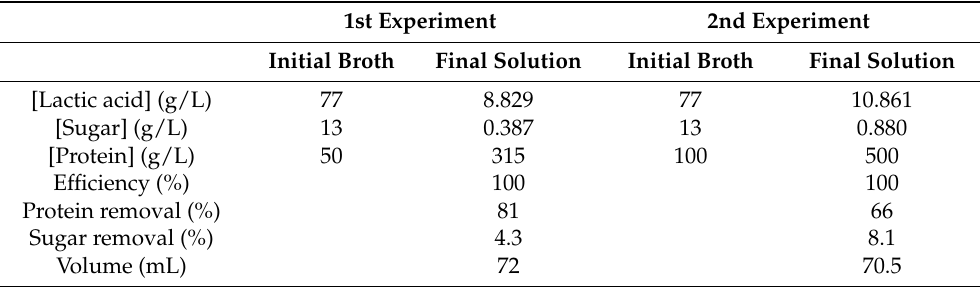
Table 9. Results obtained in purification using broth with pH